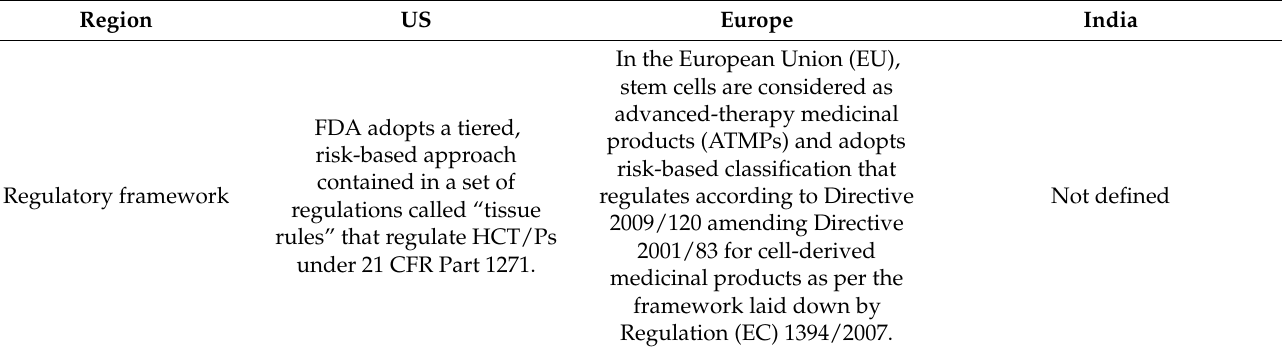
Table 2. Regulatory frameworks for biological products in the US, Europe, and